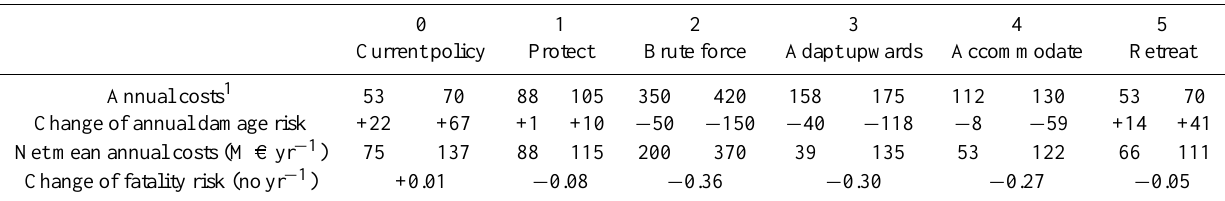
Table 3. Costs of the strategic alternatives and their effect in terms of change of risk, comparing strategy in place ( = 2050) with “system in order” ( =